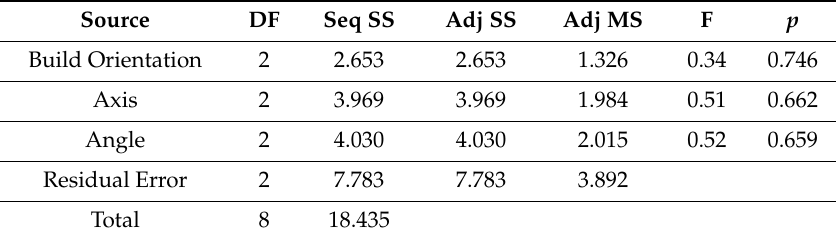
Table 4. ANOVA for UTS obtained through Taguchi